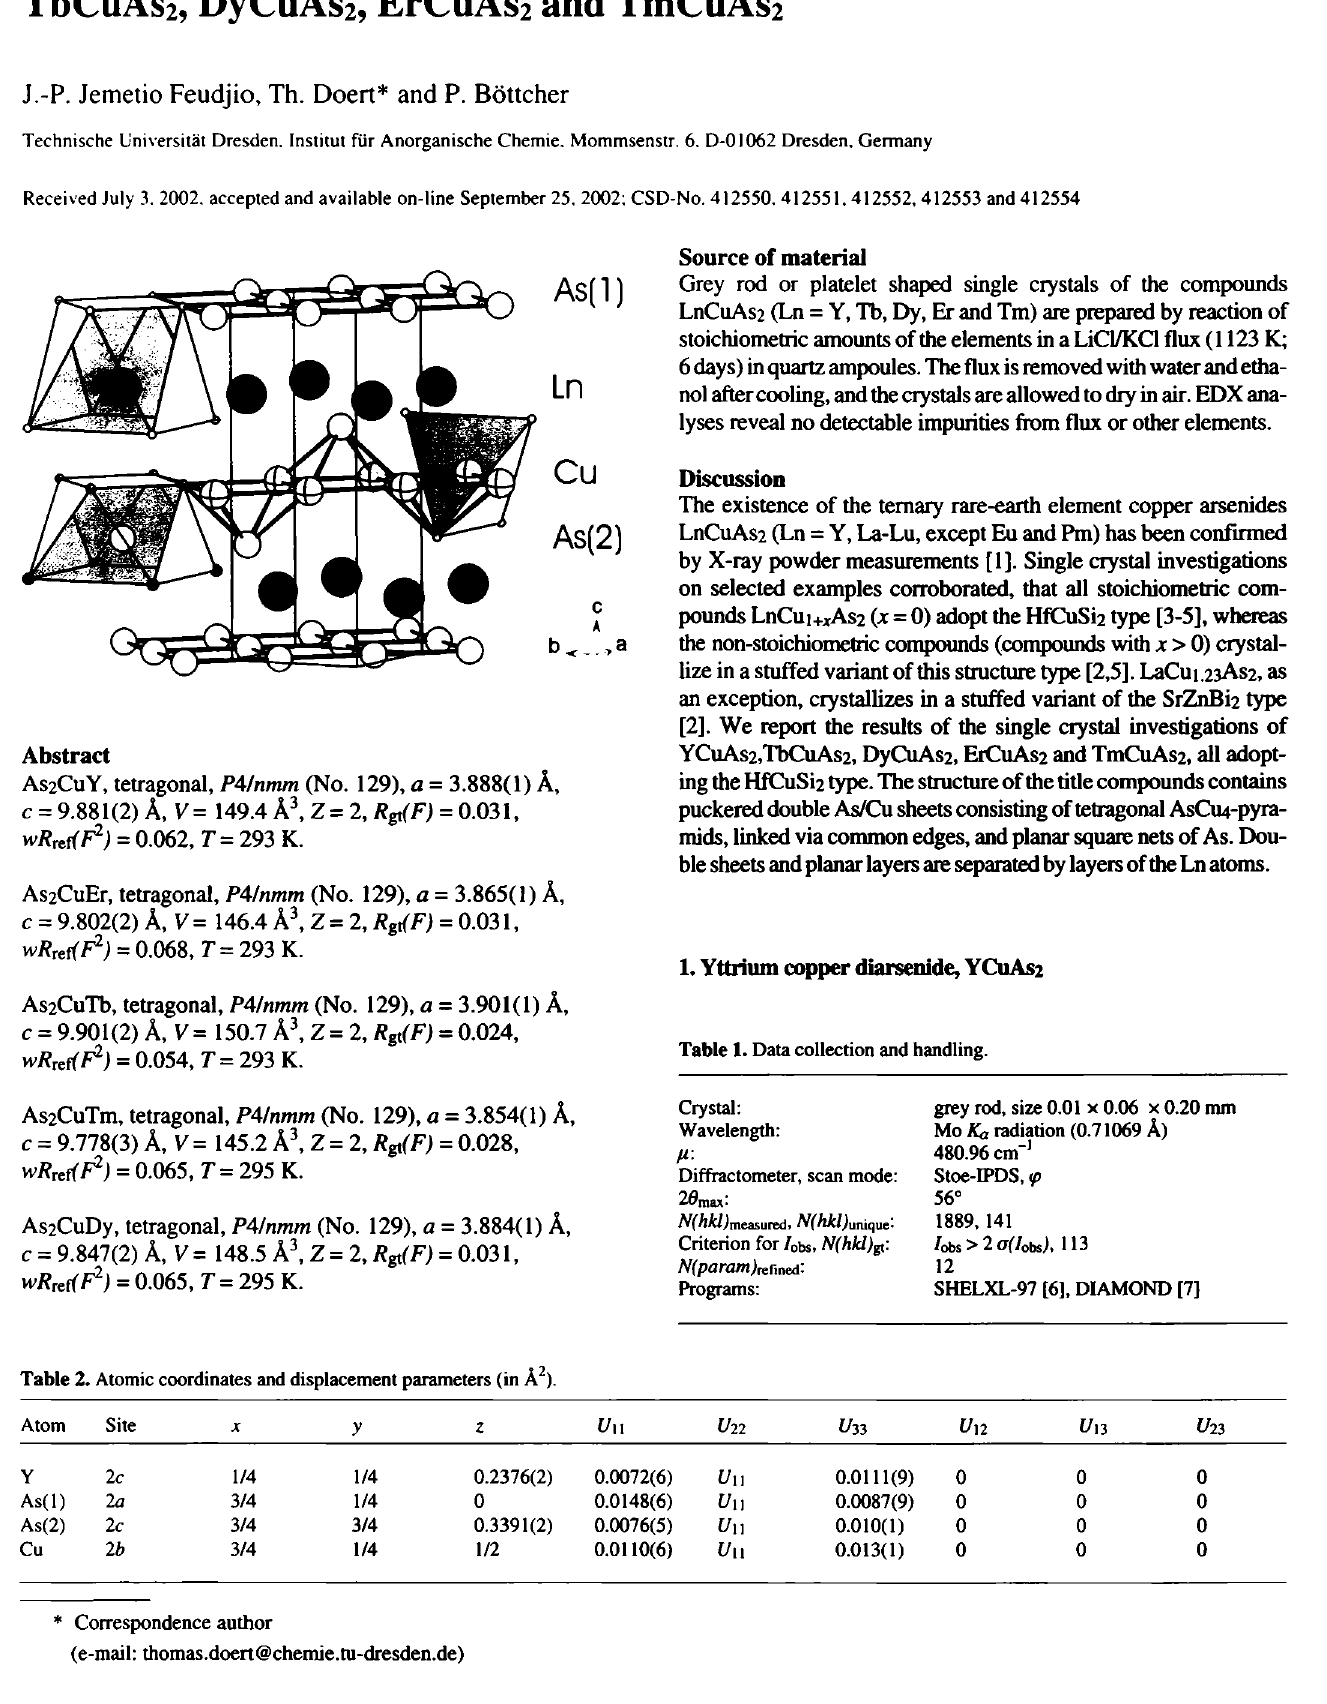
Table 2. Atomic coordinates and displacement parameters (in Â 2